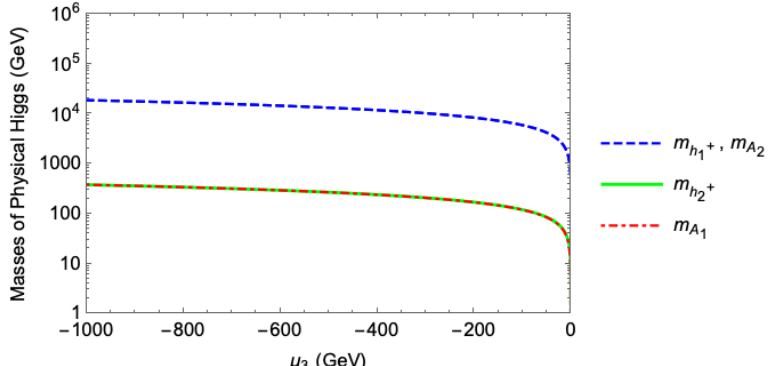
Figure 6 . Charged and pseudo-scalar Higgs boson masses as functions of µ 3 .